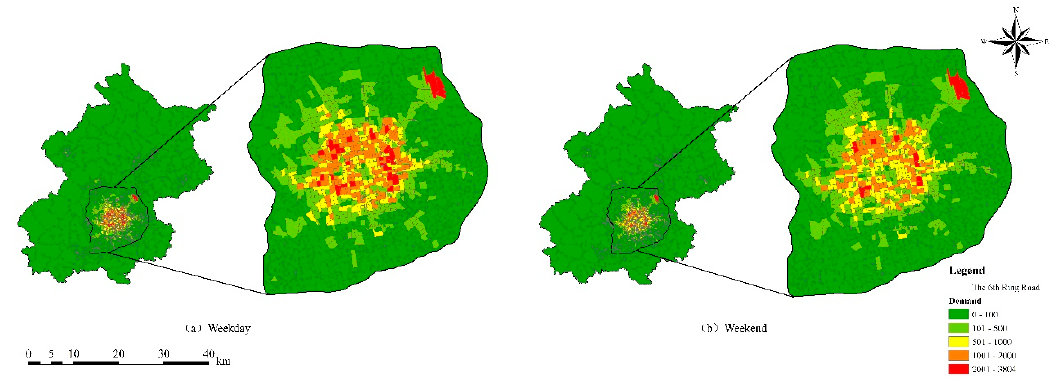
Figure 8. Distribution of residents travel demand of Beijing based on TAZ scale.